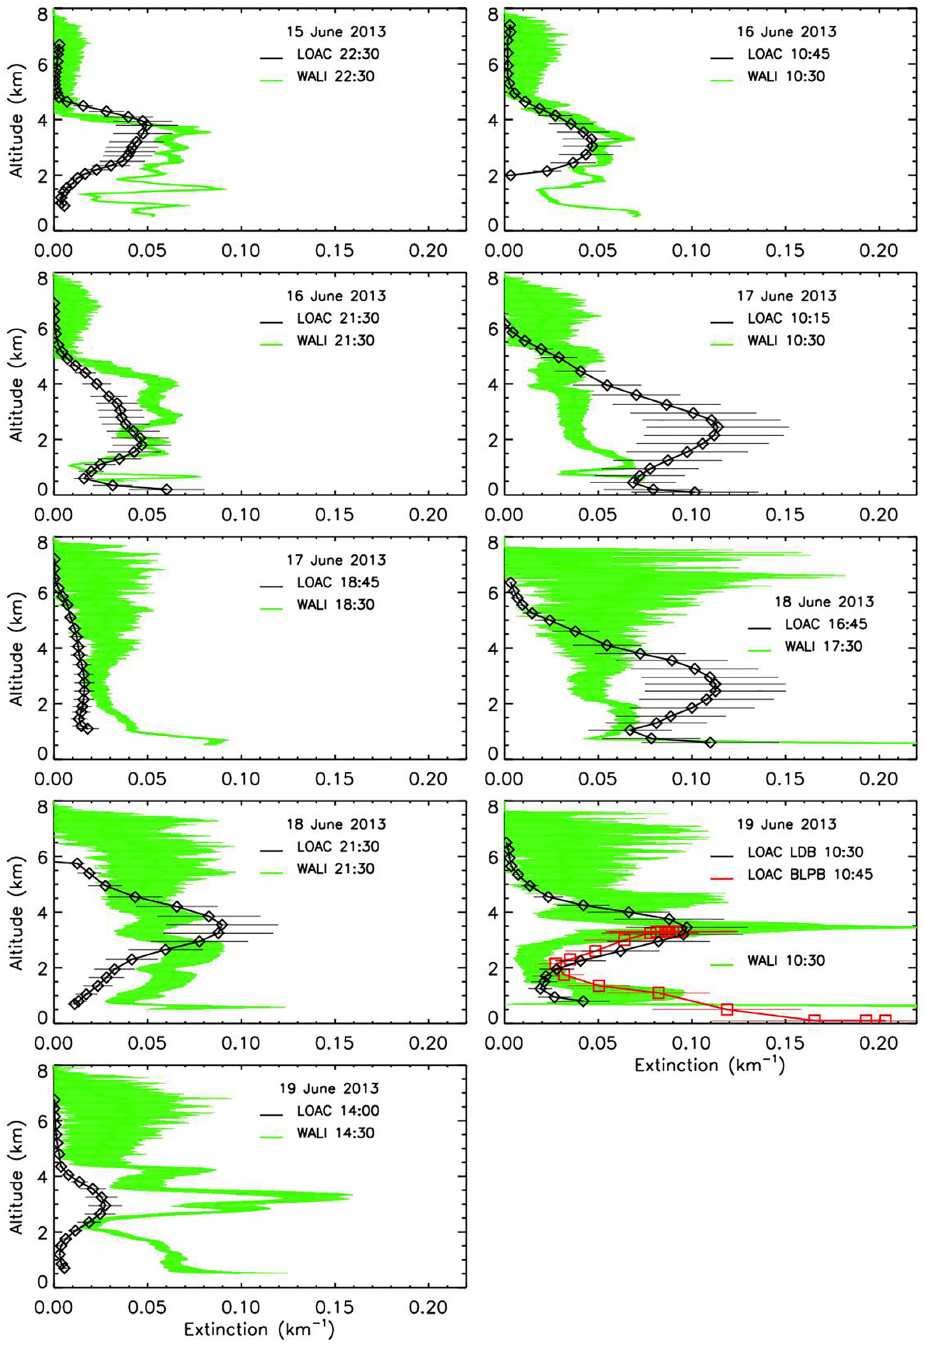
Figure 9. Comparison between LOAC and WALI extinctions at 350nm. All the WALI profiles obtained between − 30 and + 30min of the given times are plotted. The LOAC error bars consider the uncertainty in the LOAC measurements and on the counting-extinction conversion; the WALI error bars are calculated from the individual measurement